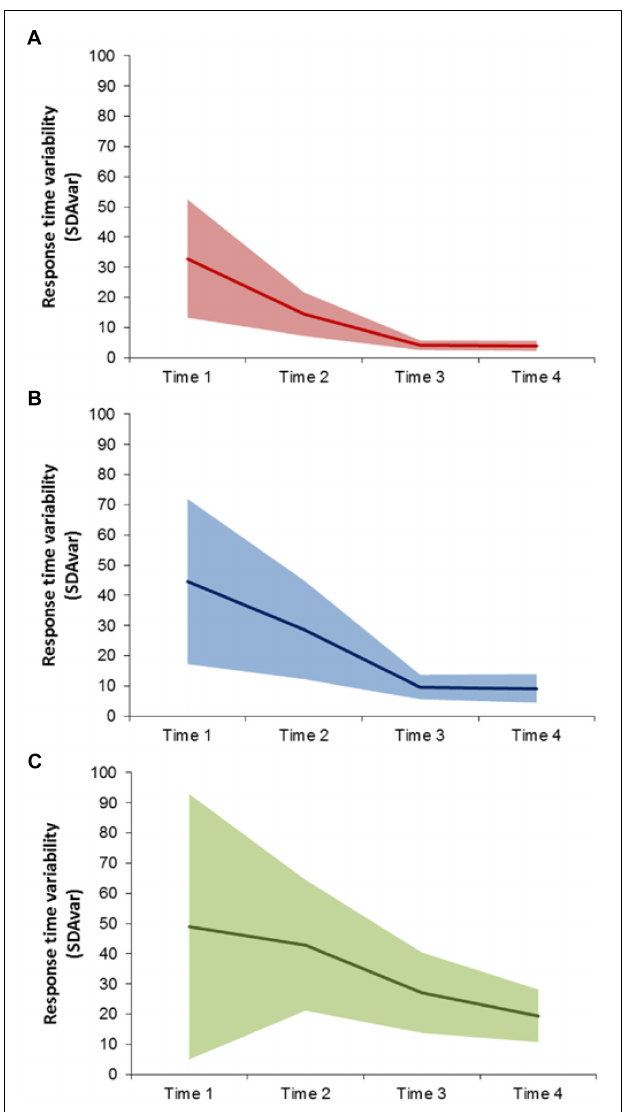
FIGURE 1 | Three profiles identified from latent profile analysis of SDA problem solving response time variability (SDA var ) assessed at 6-, 7-, 9, and 10-years (A) Typical, (B) Delayed and (C) Deficit pathways. Solid line represents profile mean SDA var and shaded region represents ± 1 standard